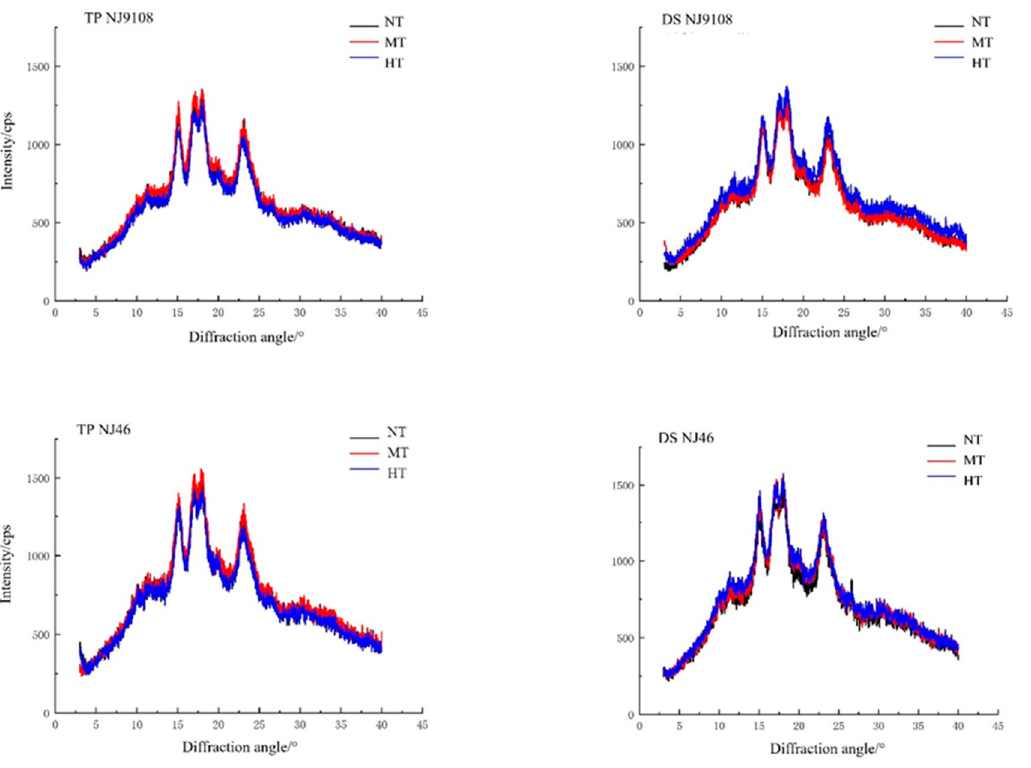
Figure 6. Effects of high temperature on starch crystal structure of japonica rice in middle heading stage under transplanting and direct seeding.